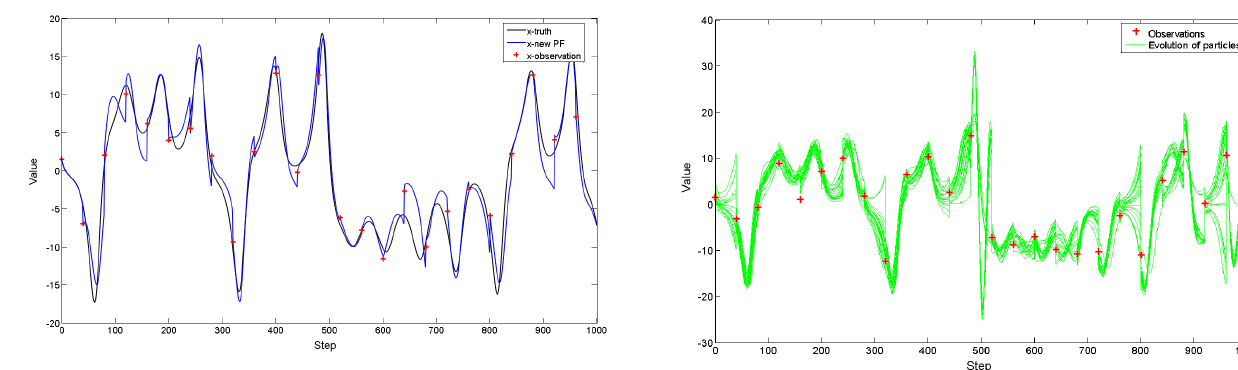
Figure 3. The evolution of posterior particles in time. The green dashed lines show the traces of all particles; the red crosses denote the observations.